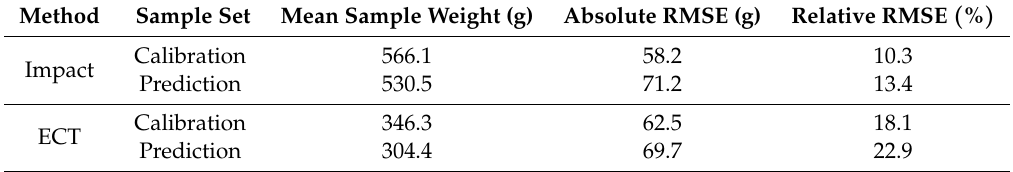
Table 1. Summary of root mean square error for the two mass flow rate prediction